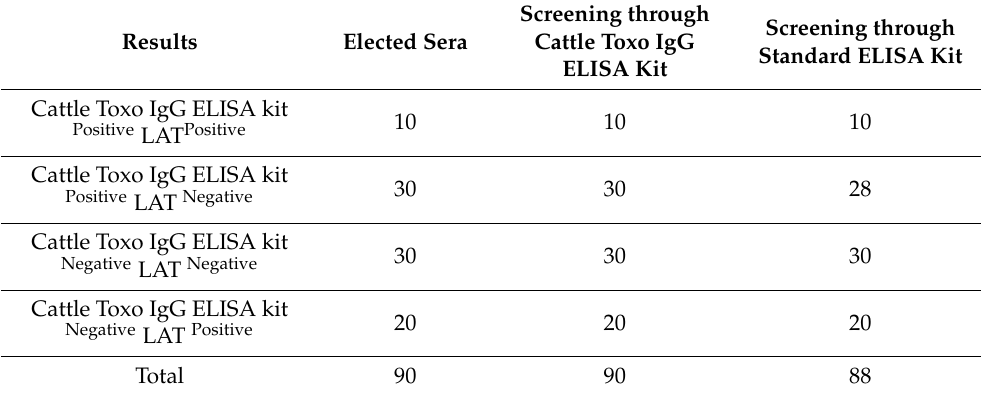
Table 4. The results of 90 cattle sera tested by Standard ELISA kit for detection of anti- T. gondii